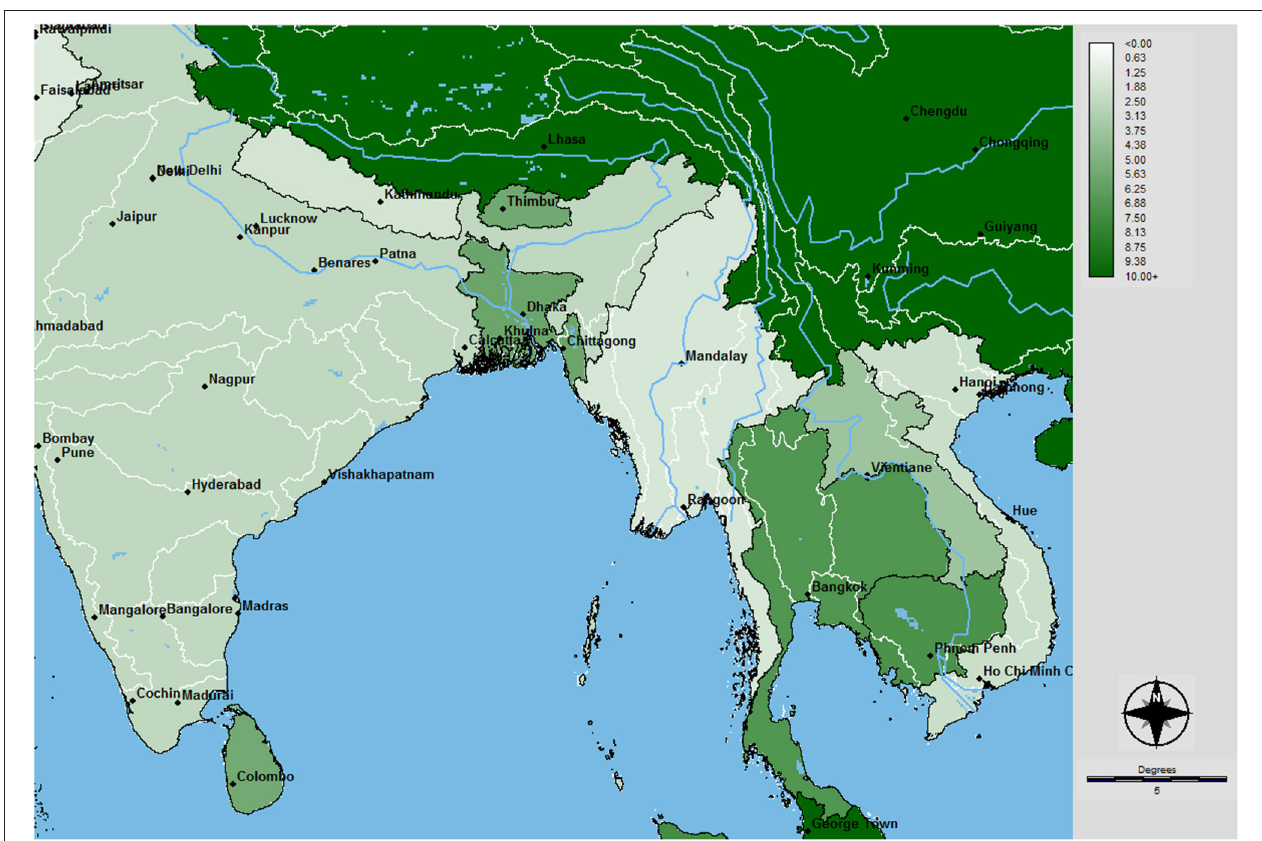
FIGURE 3 | Water use efficiency (US$ m − 3 ): current national average values of countries included in the frame of the study